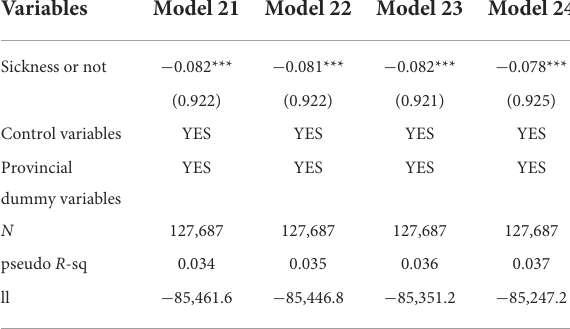
TABLE 9 Robustness test regression results